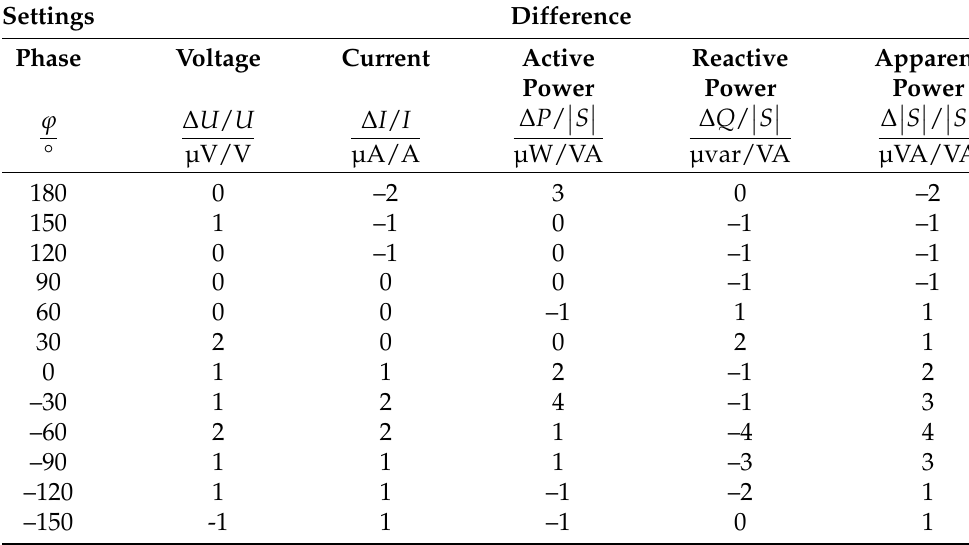
Table 7. Comparison results (120V and